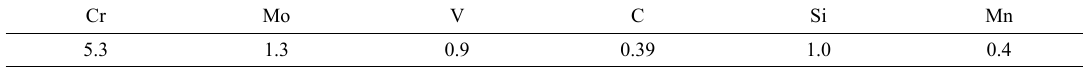
Table 2. Duplex treatment process parameters for surface modifications. Process Temp.